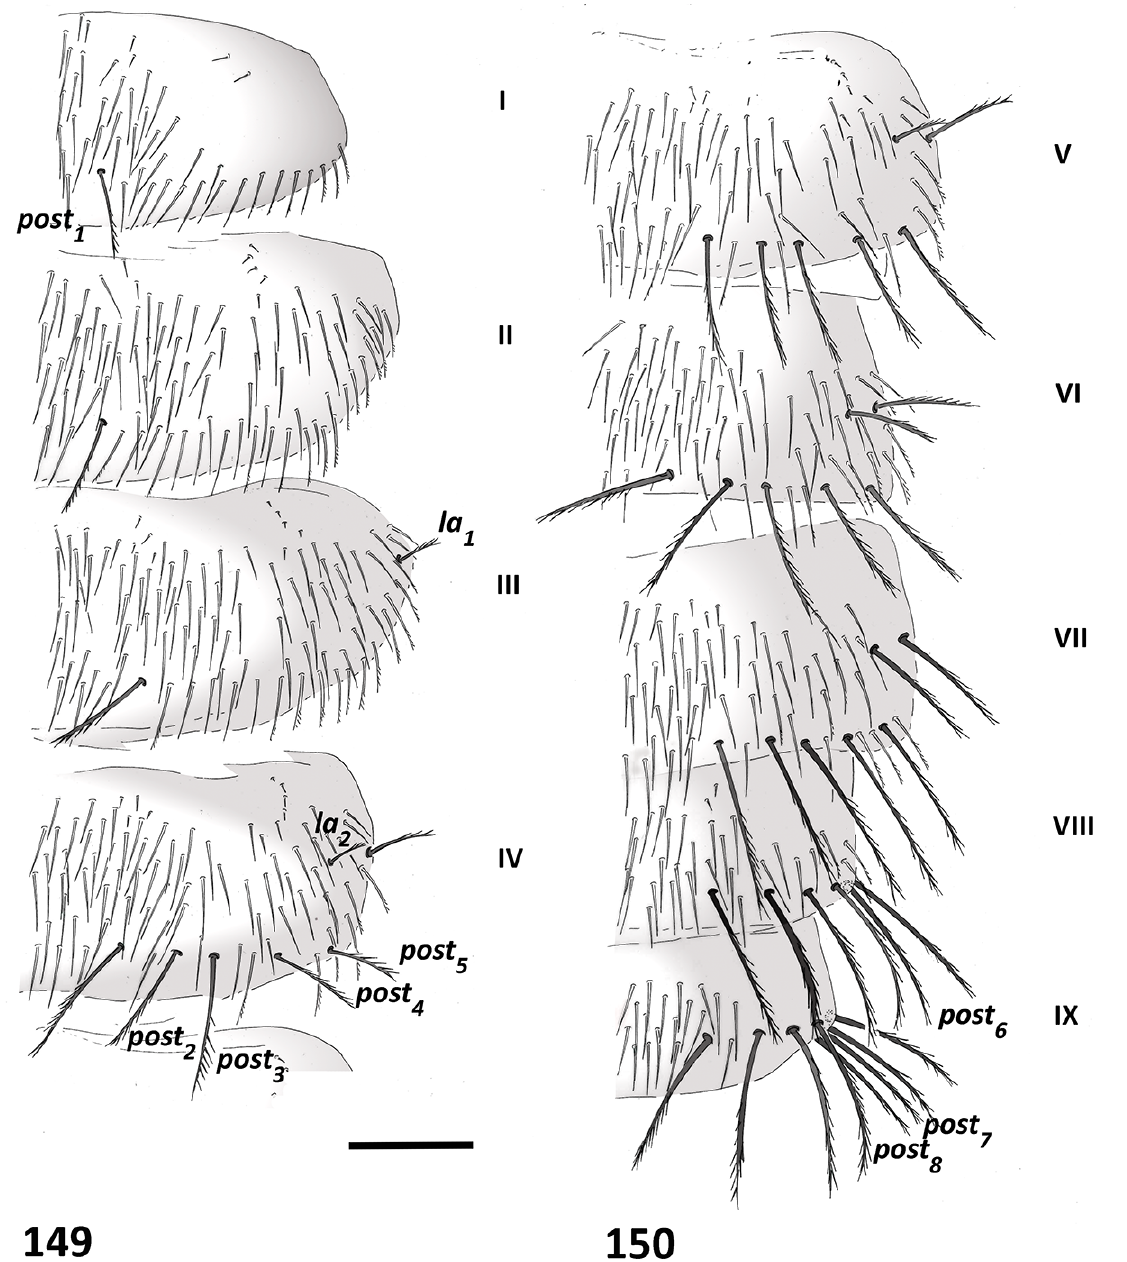
Figs 149–150. Plusiocampa ( Plusiocampa ) strouhali cavicola Vornatscher, 1943, from Odelsteinhöhle, Styria, Austria (Coll. AS). 149 . Urotergites I–IV, right side. 150 . Urotergites V–VIII and abdominal segment IX, right side ( s = setiform sensillum). Scale bar: 0.2